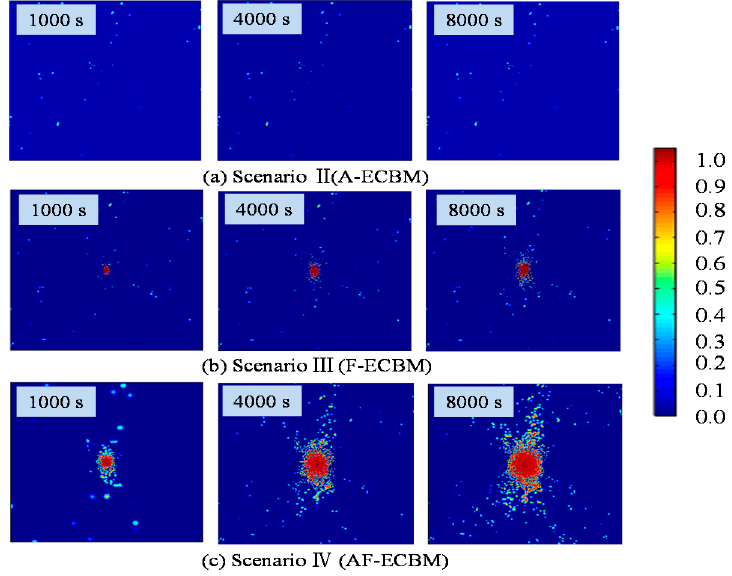
Figure 6. Damage distribution of different stimulation methods after treated different times.